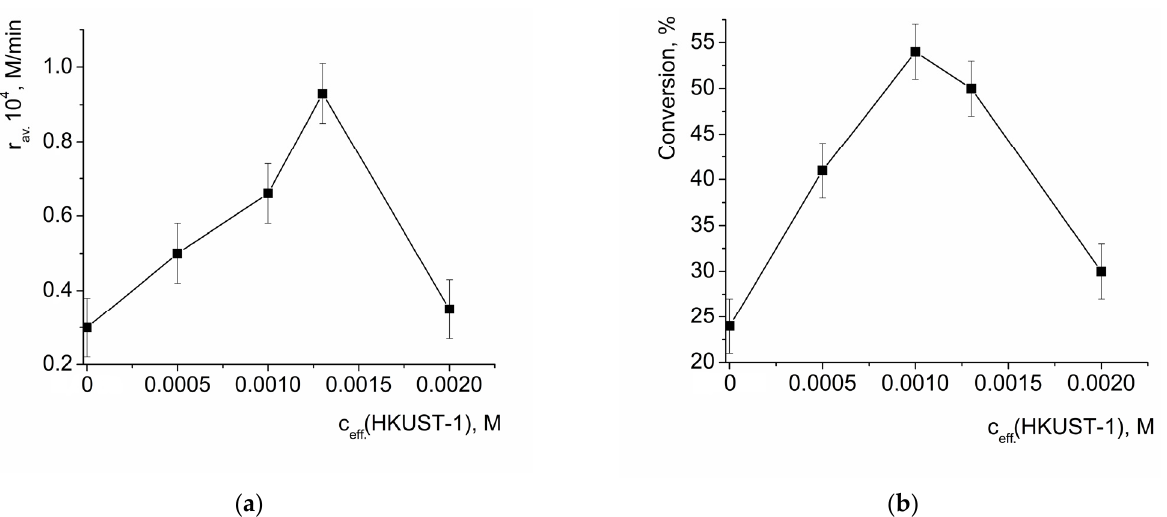
Figure 6. Dependency of the average initial reaction rate of benzoin oxidation by H 2 O 2 ( a ) and benzoin conversion after 3 h of reaction ( b ) on the initial effective concentration of HKUST-1. c(benzoin) = 0.033 M, c(H 2 O 2 ) = 3.3 M.